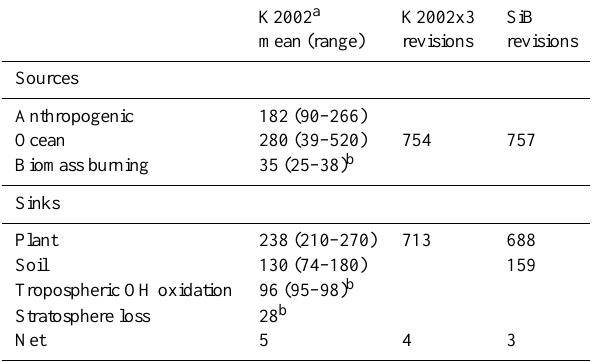
Table 3. Annual global atmospheric OCS budget (fluxes inGgSyear − 1 )